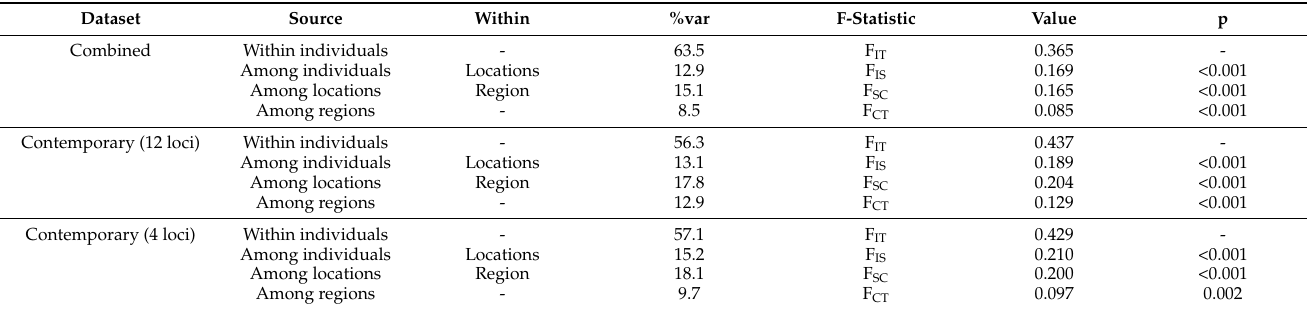
Table 3. Summary of analysis of molecular variance for each dataset. The percentage of molecular variance (%var) assignable to each hierarchical population level is given, together with the appropriate F-statistic. For variance above the individual level, the statistical significance of the difference of the value from zero is given based on 9999 permutations.